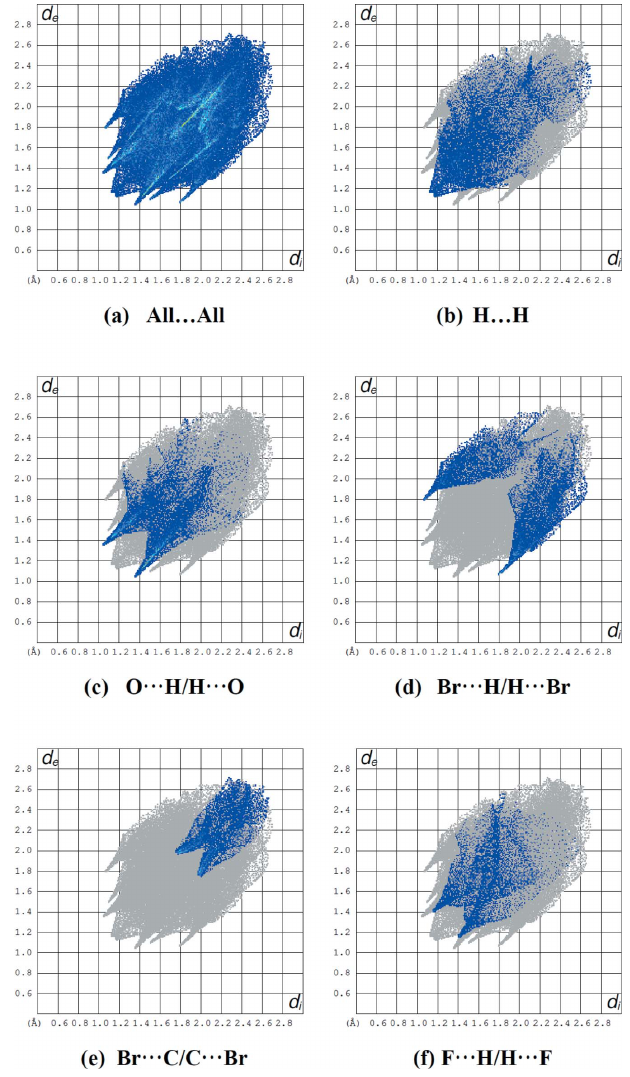
Figure 4 The full two-dimensional fingerprint plot ( a ) for the title compound and those delineated into ( b ) H (cid:2)(cid:2)(cid:2) H (17.4%), ( c ) O (cid:2)(cid:2)(cid:2) H/H (cid:2)(cid:2)(cid:2) O (16.3%), ( d ) Br (cid:2)(cid:2)(cid:2) H/H (cid:2)(cid:2)(cid:2) Br (15.5%), ( e ) Br (cid:2)(cid:2)(cid:2) C/C (cid:2)(cid:2)(cid:2) Br (10.1%) and ( f ) F (cid:2)(cid:2)(cid:2) H/H (cid:2)(cid:2)(cid:2) F (8.1%)